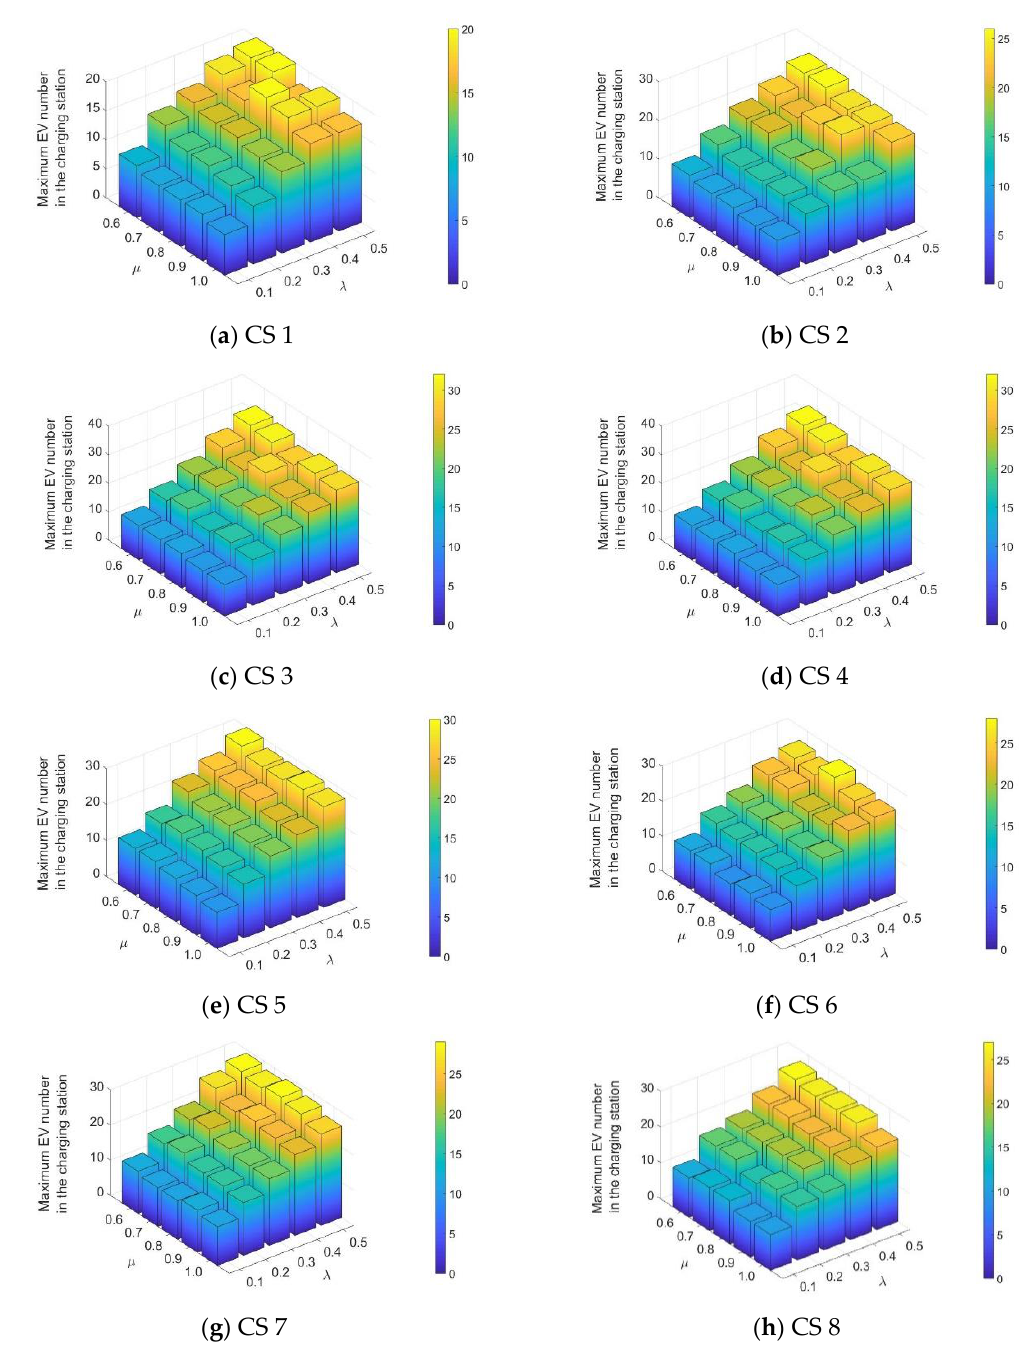
Figure 9. Change trends of the maximum EV number in each charging station under the CSB strategy, where λ is the possibility of charging demand occurrence in normal nodes at each time slot, and μ is the possibility of an EV leaving the charging station after completing charging at each time slot.